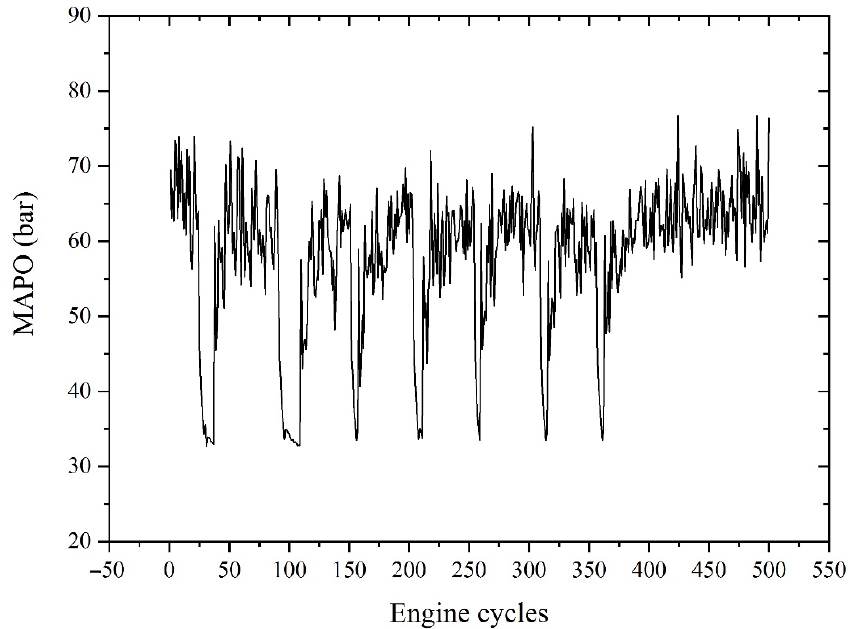
Figure 3. The maximum amplitude of pressure oscillations (MAPO) time trace for the four differ ‐ ent cylinders.